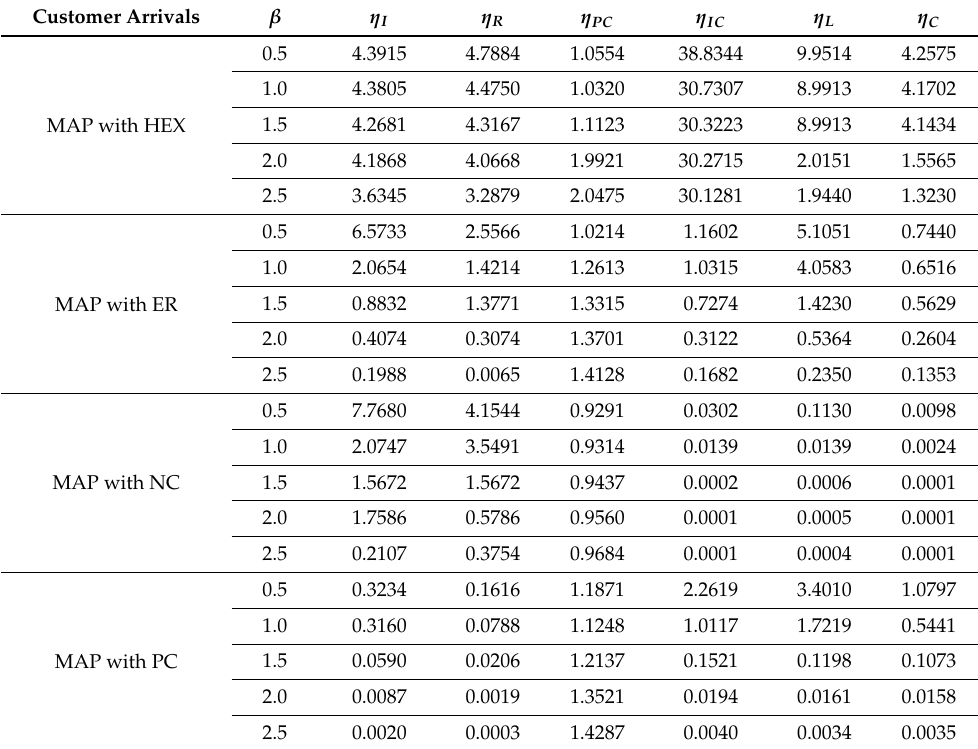
Table 7. Ramification of MAP with ER, NC and PC for ( S , s , θ , µ ) = (21, 7, 10.5, 2.5).